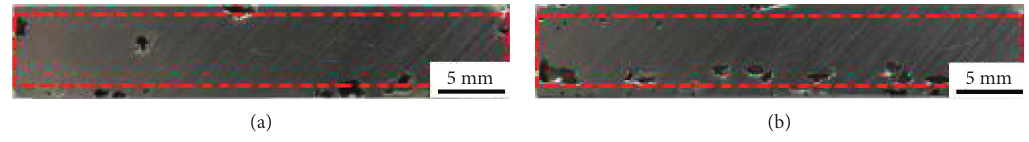
Figure 11: Macromorphology of pitting specimen. (a) 98%Ar +2%N